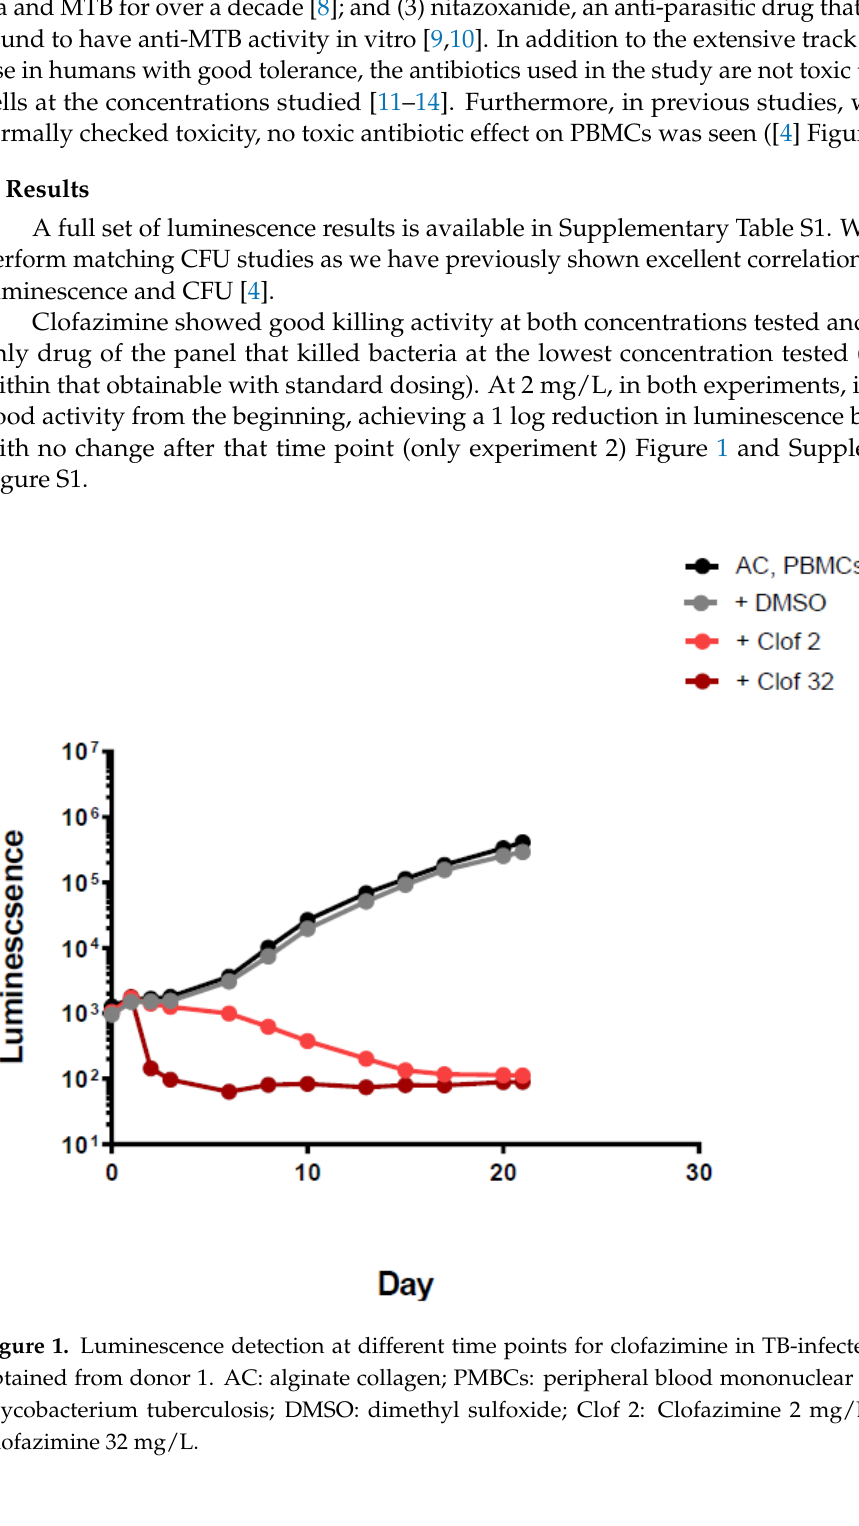
Figure 2. Luminescence detection at different time points for nitazoxanide in TB-infected PMBCs obtained from donor 1. AC: alginate collagen; PMBCs: peripheral blood mononuclear cells; Mtb: Mycobacterium tuberculosis; DMSO: dimethyl sulfoxide; Nita8: Nitazoxanide 8 mg/L; Nita 64: Nita- zoxanide 64 mg/L.